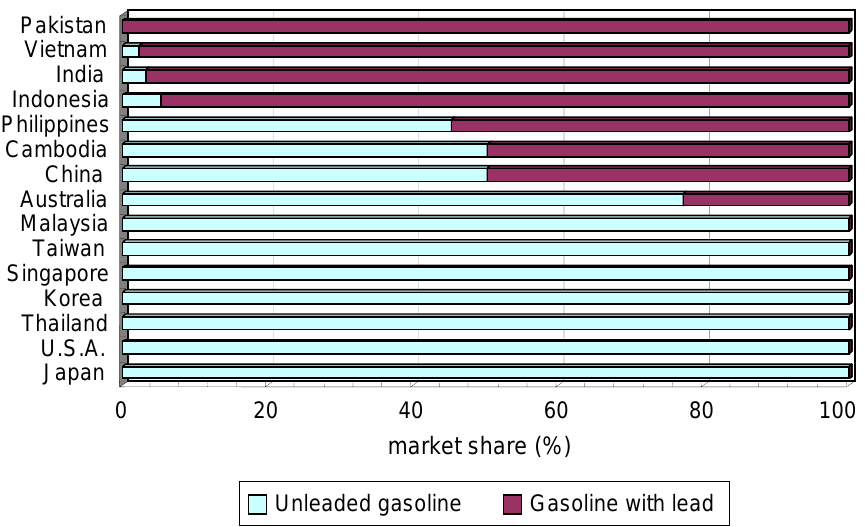
Figure 8. Share of leaded fuel in APEC member